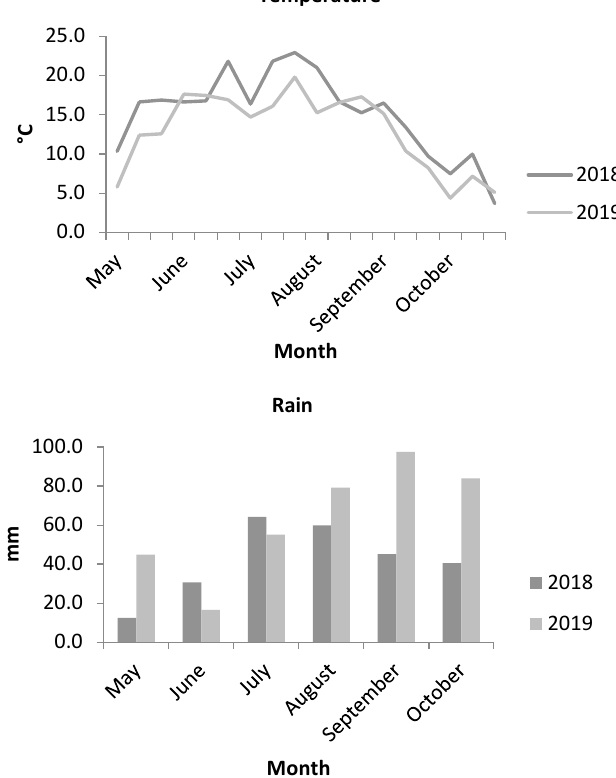
Fig. 1. Mean temperatures (°C) and monthly rainfall (mm) in field conditions in Lohja, Finland (Finnish Meteorological